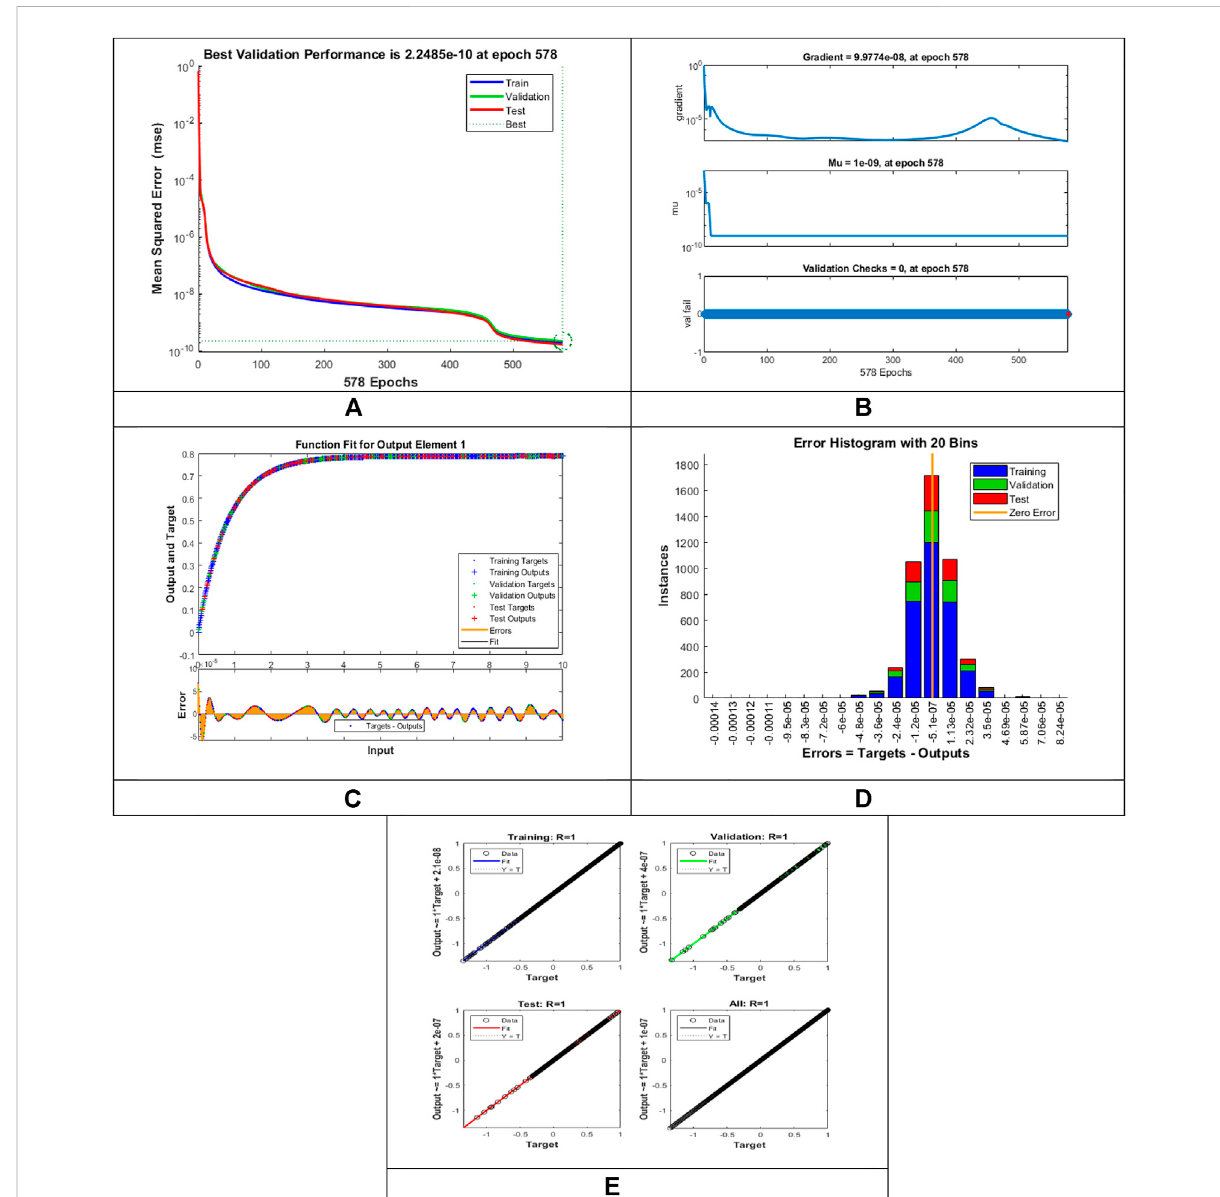
FIGURE 4 PictorialillustrationfortheLMLA-BPNNbaseonvariantsof Mvsf ′ ( η ) forMHD-WNF-HGA. (A) M-S-Edemonstration, (B) transitionstateanalysis, (C) curve fi tting, (D) error histogram, and (E) regression